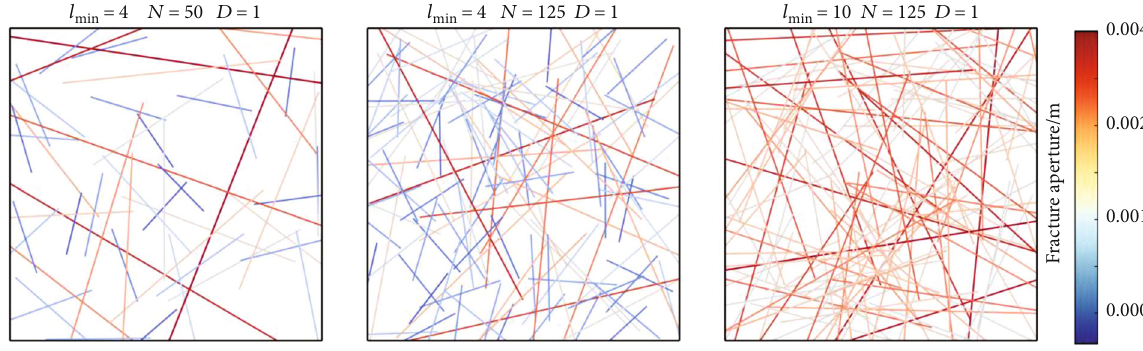
Figure 2: Discrete fracture models with correlated fracture aperture and length.